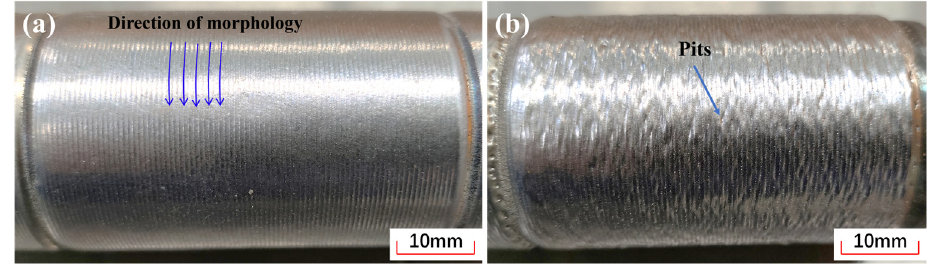
Figure 7. Macro-morphology of EHLA coating. ( a ) Macro-morphology under stable process parameters; ( b ) macro-morphology under fl uctuating process parameters.